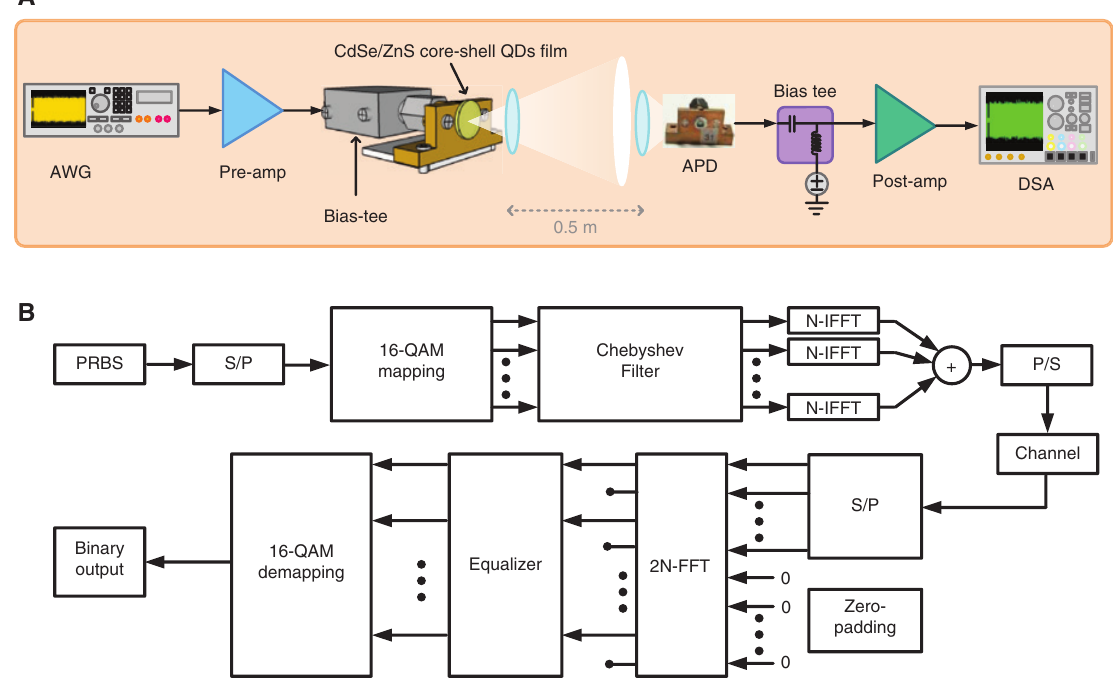
Figure 3: Experimental and modulation scheme of the VLD + CdSe/ZnS core-shell-QD-based white-lighting VLC system. (A) Experimental setup of 0.5-m VLD + CdSe/ZnS core-shell-QD-based white-lighting VLC system. (B) The block diagram for the algorithm of the 16-QAM DMT